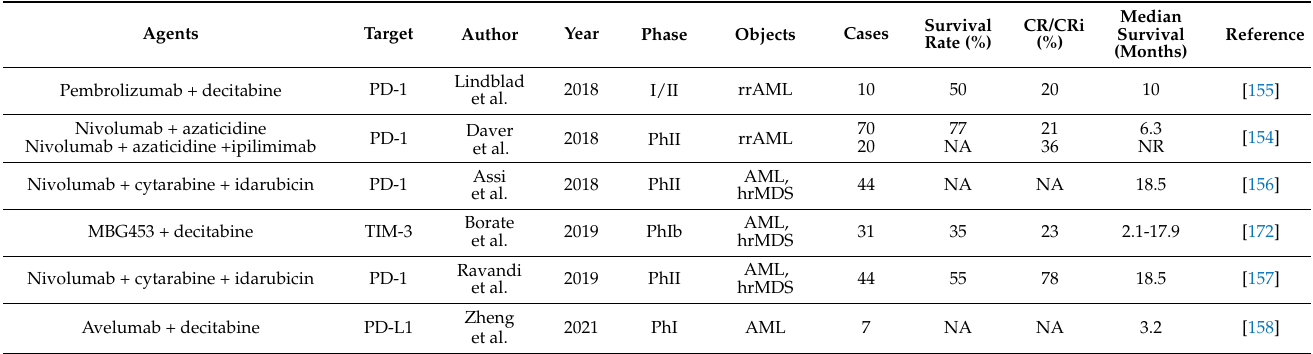
Table 4. Summary of clinical trials combining ICIs and conventional drugs for the treatment of AML and/or